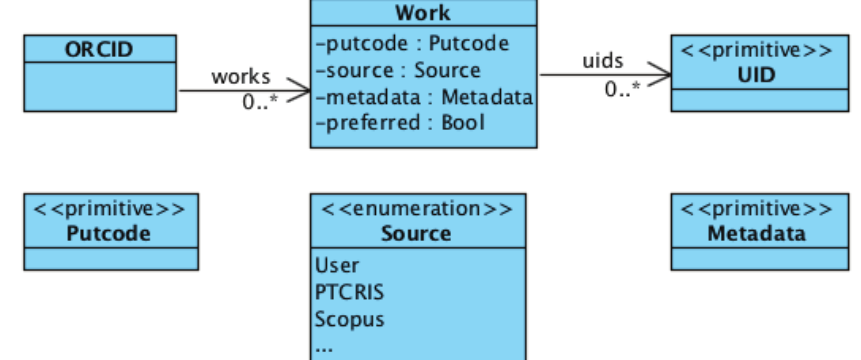
Figure 2. Overview of the ORCID data